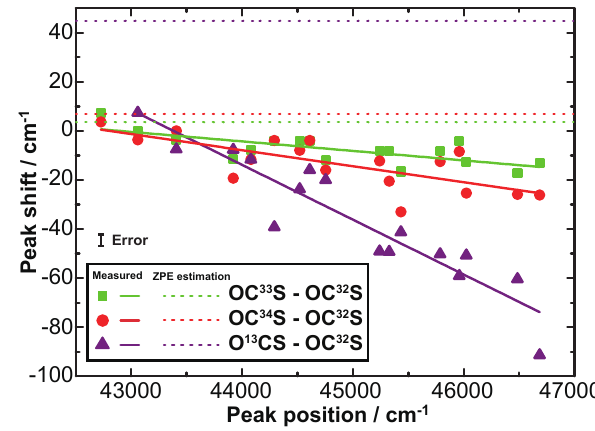
Fig. 3. Isotopic shift for the 210–230nm region. The shift in the position of vibrational structure for the OC 33 S, OC 34 S, and O 13 CS isotopologues relative to OC 32 S are shown. Dotted line shows shifts using the 1 ZPE model calculated in Danielache et al.